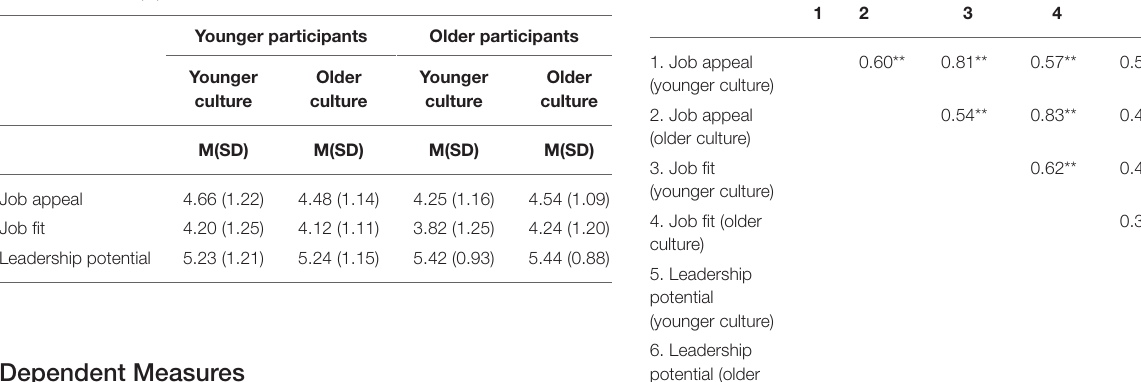
TABLE 7 | Study 3: means and standard deviations for job appeal, job fit, and self-rated leadership potential.